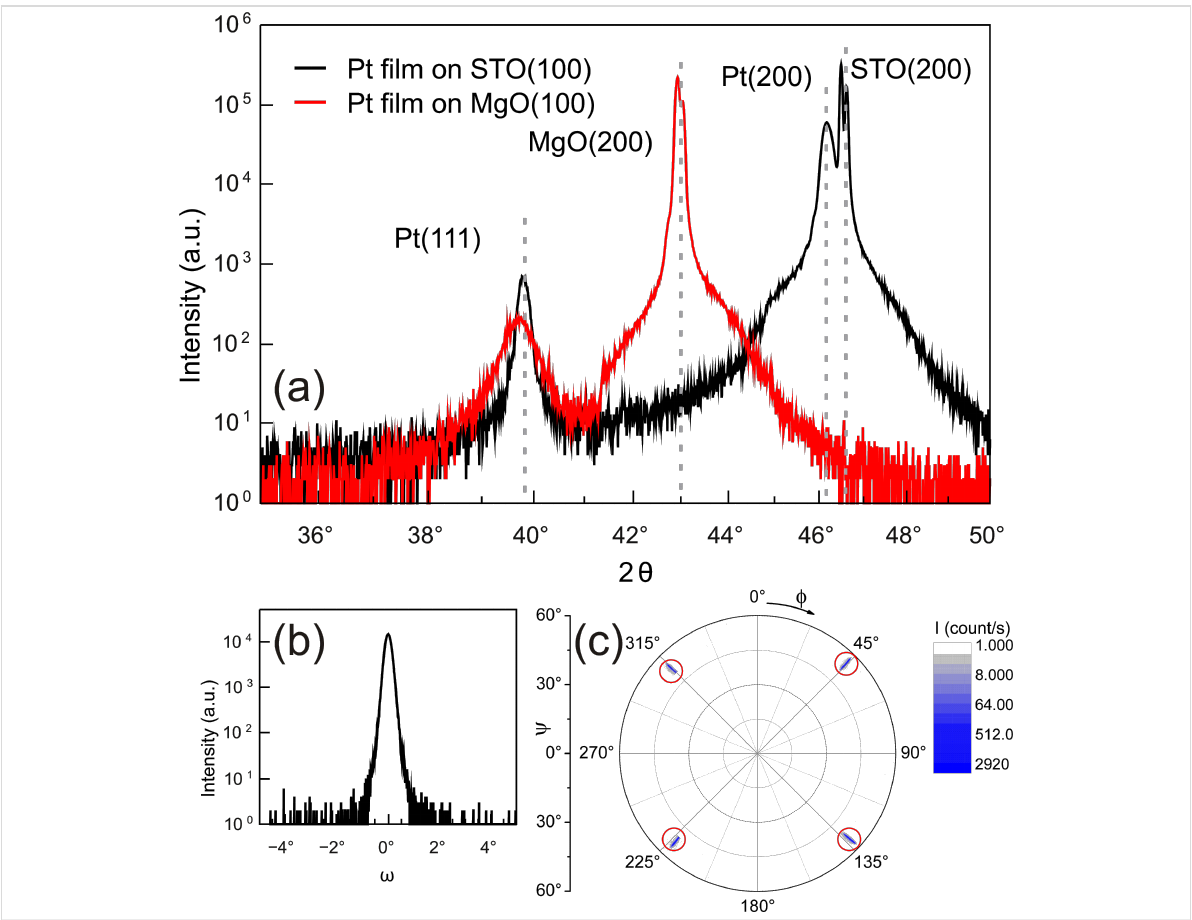
Figure 1: (a) XRD of Pt films on STO(100) and MgO(100) in Bragg–Brentano geometry. The diffractograms clearly show the two different orienta- tions of Pt films when deposited on MgO(100) at ambient temperature or STO(100) at 600 °C. Panel (b) shows the rocking curve on the Pt(200) peak of Pt/STO(100). Panel (c) displays the Pt/STO(100) pole figure measured on the Pt(111) peak position. Diffraction peaks are highlighted by red circles. Details are given in the